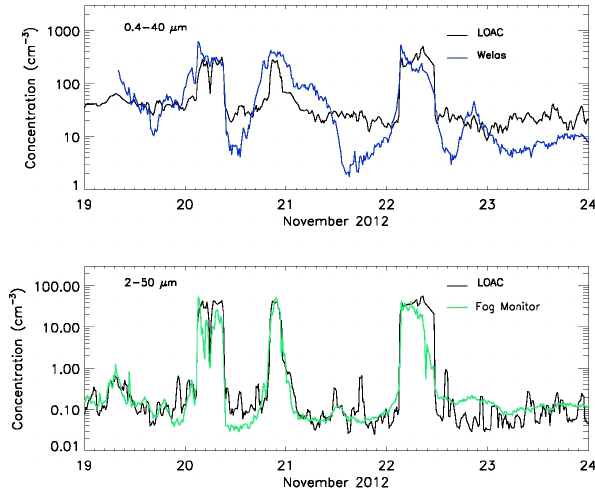
Figure 9. Comparison of LOAC measurements with DMPS and FIDAS measurements performed at the sea spray aerosol simu- lation chamber at Stockholm University. Top: concentration size distributions for sea spray aerosol particles still containing water (droplets; upper left panel) and at dry or crystalline state (salt; up- per right panel). Bottom: integrated number concentration for the 0.2 to 0.9µm (lower left panel) and 0.3 to 0.9µm (lower right panel) vs. time of the experiment while the water temperature decreased; the transition from seawater droplets to crystalline salt particles (at T = 23 ◦ C) is indicated as well.